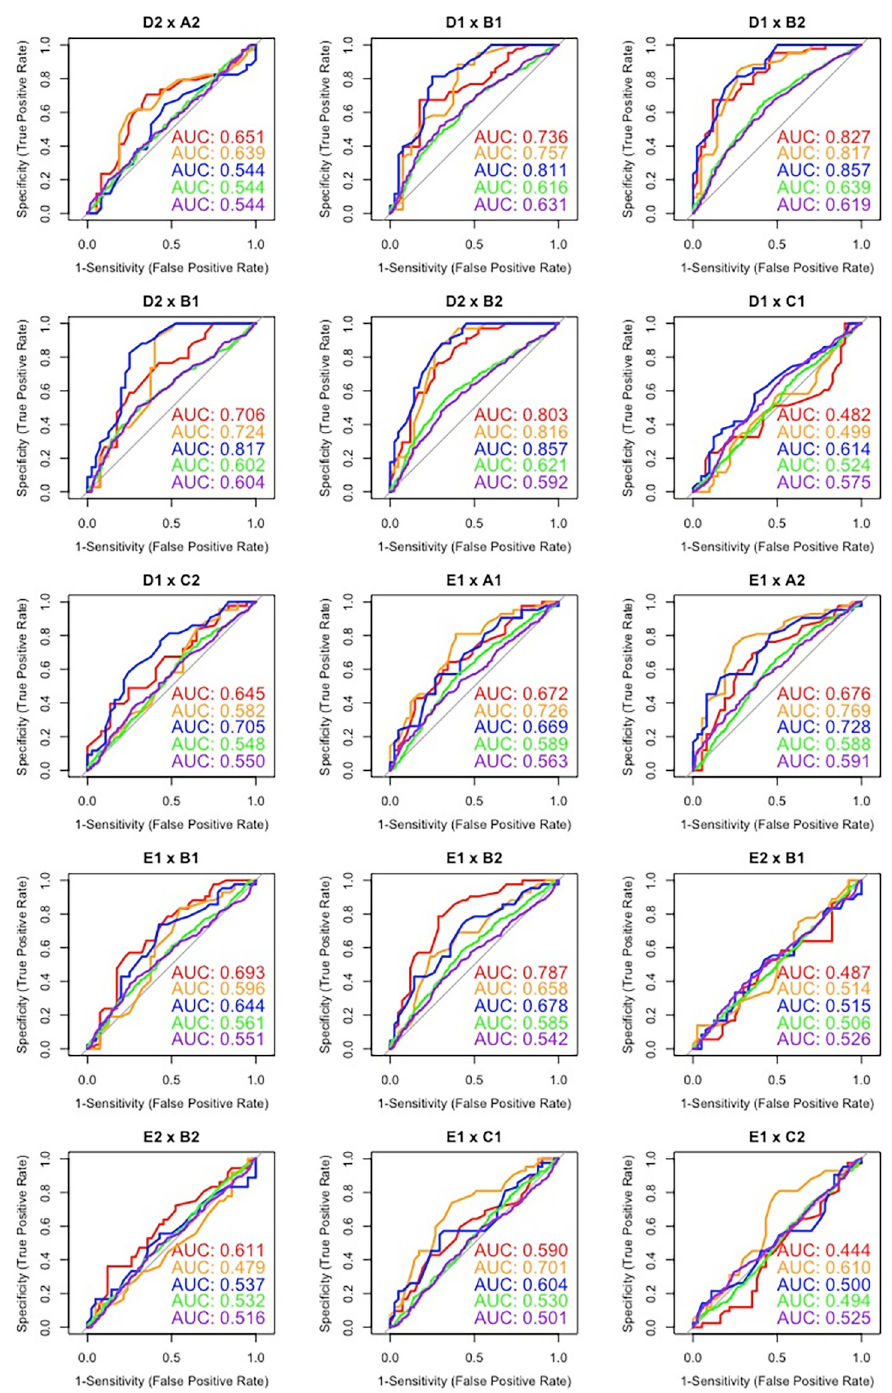
Fig 5. ROC curves and AUC values for cross-pair comparisons (II).